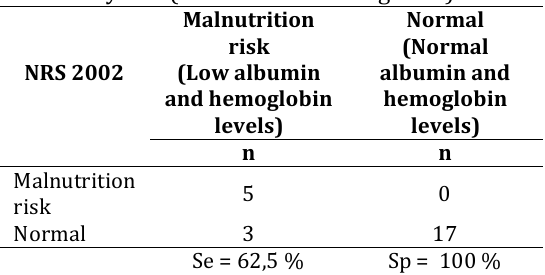
Table 1. The results of the test validity (specificity and sensitivity) in relation to the use of Nutritional Risk Screening (NRS-2002) used to calculate the risk of malnutrition as seen from the laboratory test (albumin and hemoglobin)